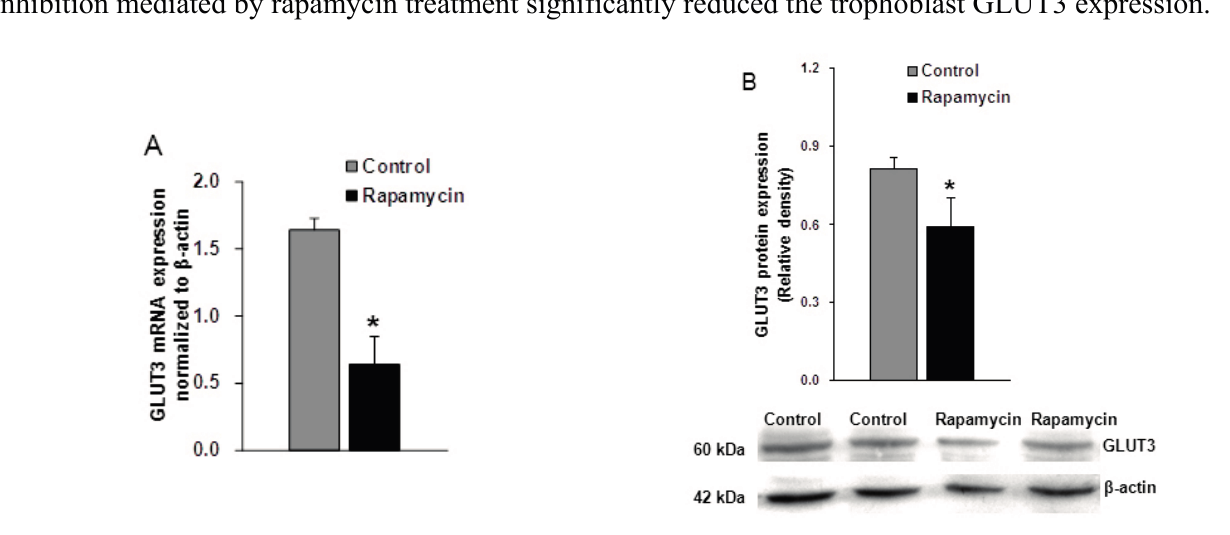
Figure 4. Effect of rapamycin on the expression of trophoblast GLUT3. ( A ) Effect of rapamycin on the mRNA expression of GLUT3. The expression of GLUT3 mRNA was down-regulated by 61% in the cells incubated with rapamycin, Values are mean ± SD. n = 5, * p < 0.01 vs. control by Mann-Whitney U -test; and ( B ) Effect of rapamycin on the protein expression of GLUT3. The GLUT3 protein level was reduced by 28% in rapamycin-treated cells, Values are mean ± SD. n = 4, * p < 0.05 vs. control by Mann-Whitney U